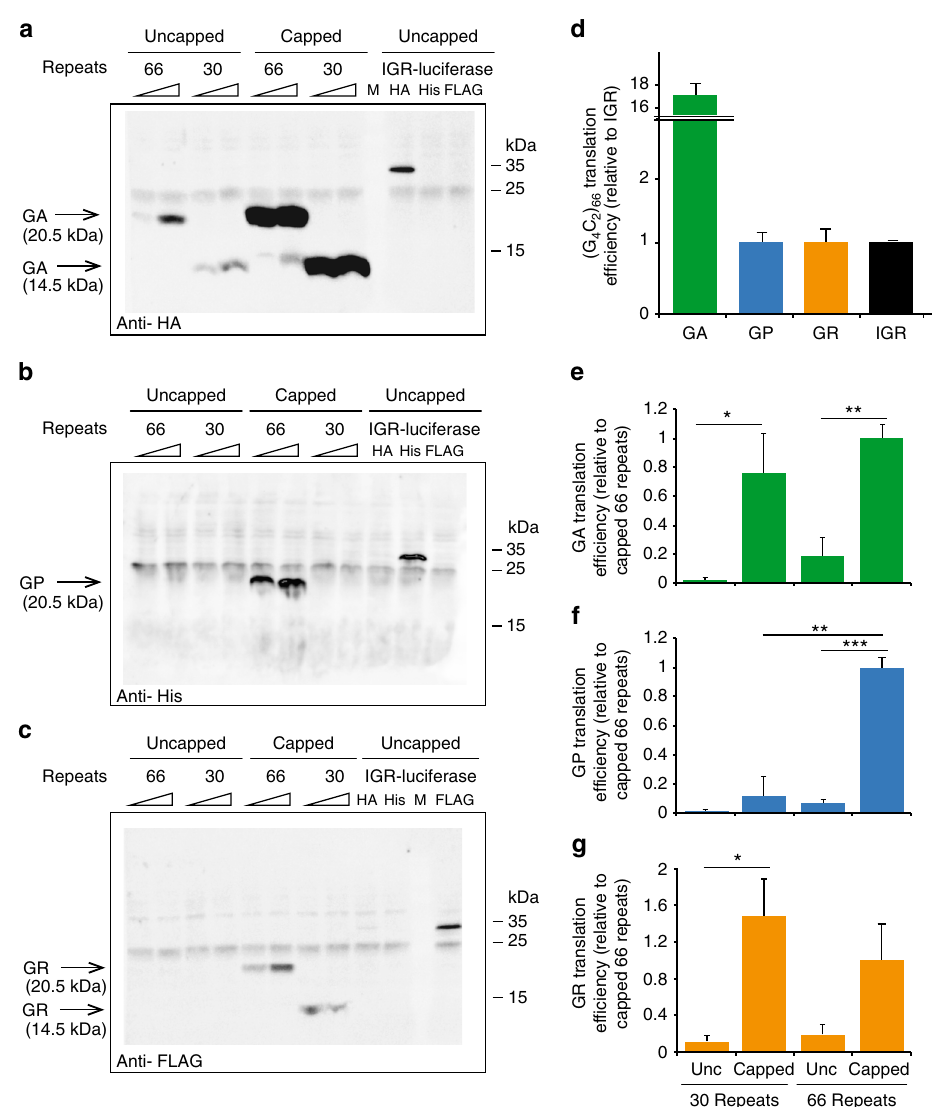
Fig. 1 G 4 C 2 RAN translation is length dependent and displays different ef fi ciencies across reading frames. RNA transcripts with (G 4 C 2 ) 30 or (G 4 C 2 ) 66 repeats were transcribed in vitro with T7 RNA polymerase, capped or not capped and subjected to translation in rabbit reticulocyte lysate (RRL) system. Increasing RNA concentrations (100 and 200 nM) were used for translation in RRL. RAN translation was probed on immunoblot with antibodies to ( a ) HA tag in the +1 poly-GA frame, ( b ) His tag in the +2 poly-GP frame, and ( c ) FLAG tag in the + 3 poly-GR frame. Schematics of constructs with 30 repeats (#3) and 66 repeats (#4) are shown in Figure S1. ( d ) Ef fi ciencies of RAN translation in the different frames were measured relatively to Renilla Luciferase with the corresponding tags driven by the intergenic region (IGR) IRES from the cricket paralysis virus. The ef fi ciencies of RAN translation from capped RNAs were compared to uncapped RNAs at 100 nM for ( e ) poly-GA, ( f ) poly-GP, ( g ) poly-GR with 30 or 66 G 4 C 2 repeats, relatively to the capped 66 repeats. Graphs represent mean ± SEM, n = 3. Student ’ s t -test, * p ≤ 0.05; ** p ≤ 0.01; *** p ≤